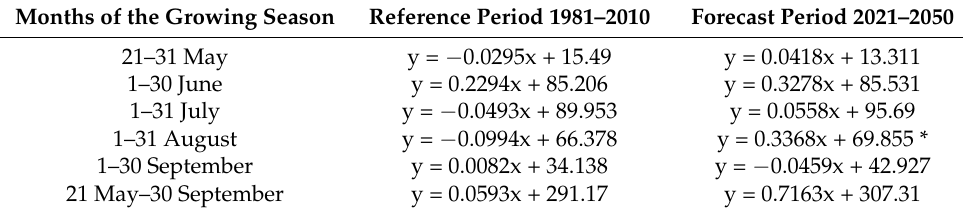
Table 4. Time trend equations of water needs of Jerusalem artichoke in the region of Kuyavia.